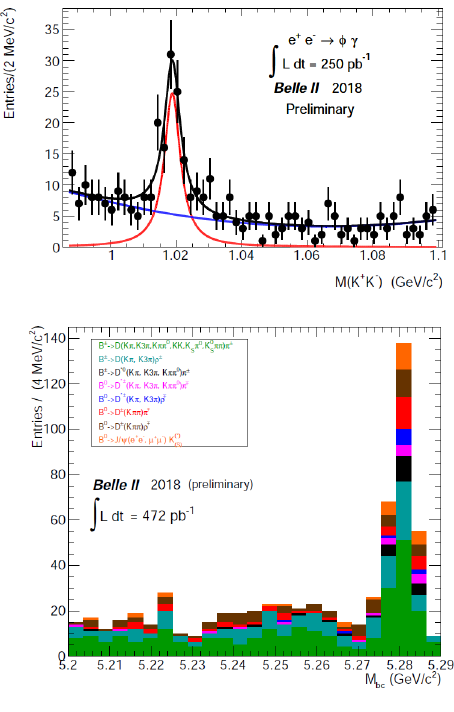
Figure 4. Reconstruction of the K + K − invariant mass distribution in the ISR process e + e − → φγ at Belle II, using 250 pb − 1 Phase-2 data. The red line refers to the MC simulations, the black line is the fit to data, the blue line is a polynomial parameterization of the background.